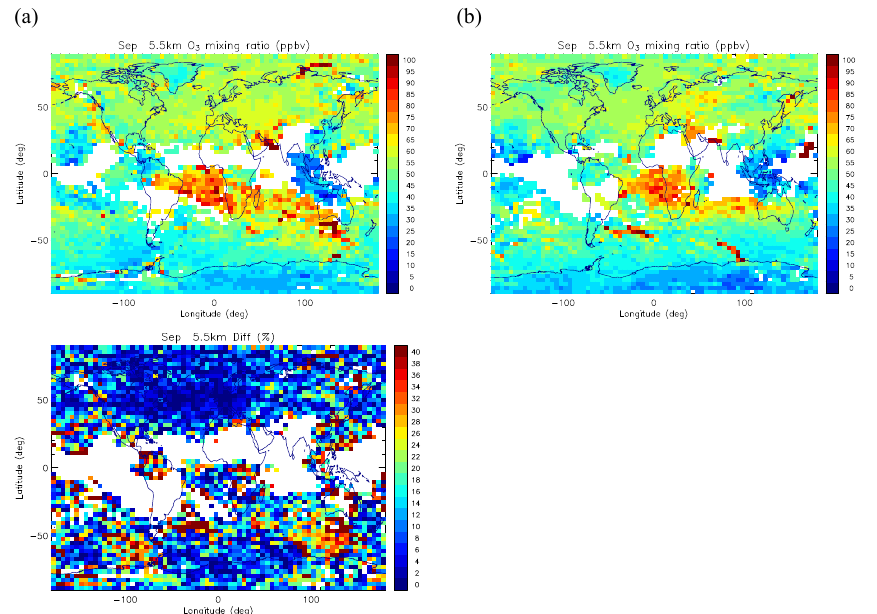
Figure 2: Ozone distribution at 5.5 km from forward (a) and backward (b) trajectory mapping. (c) Fig. 2. Ozone distribution at 5.5km from forward (a) and backward (b) trajectory mapping. (c) Difference between the two distributions in difference between the two distributions in percent. Data from 1980-2008 are used. percent. Data from 1980 to 2008 are